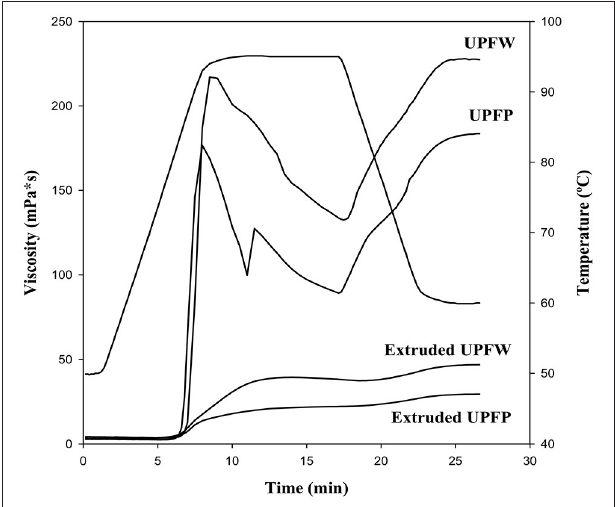
FIGURE 2 | Pasting profile of native and extruded flours of unripe plantain pulp (UPFP) and whole fruit (UPFW).